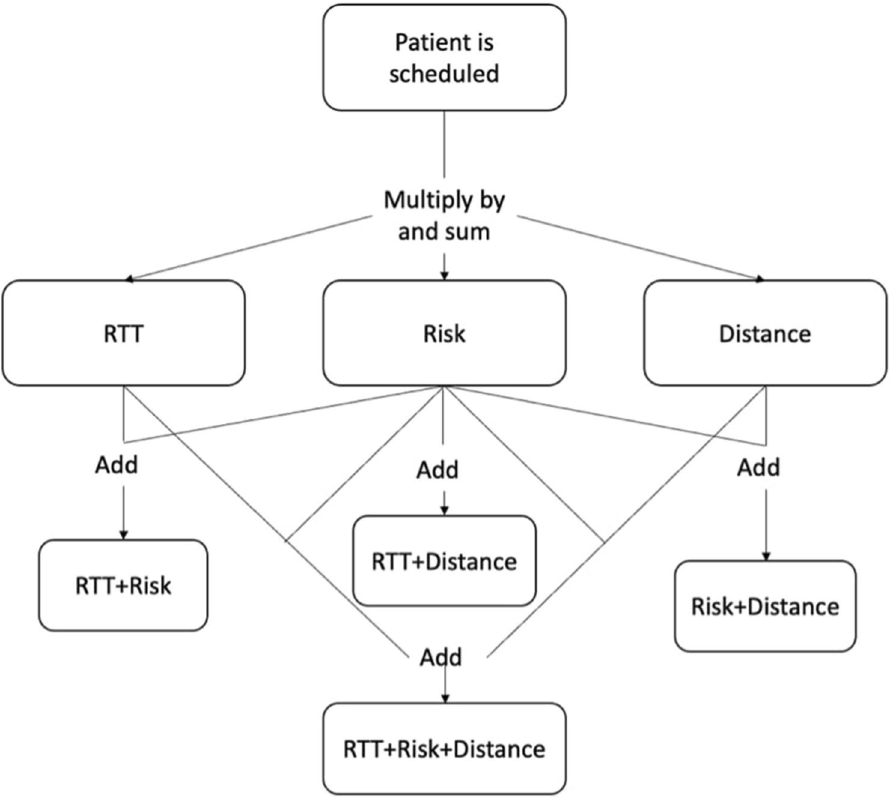
Figure 4. Schematic of model showing how the objective functions are